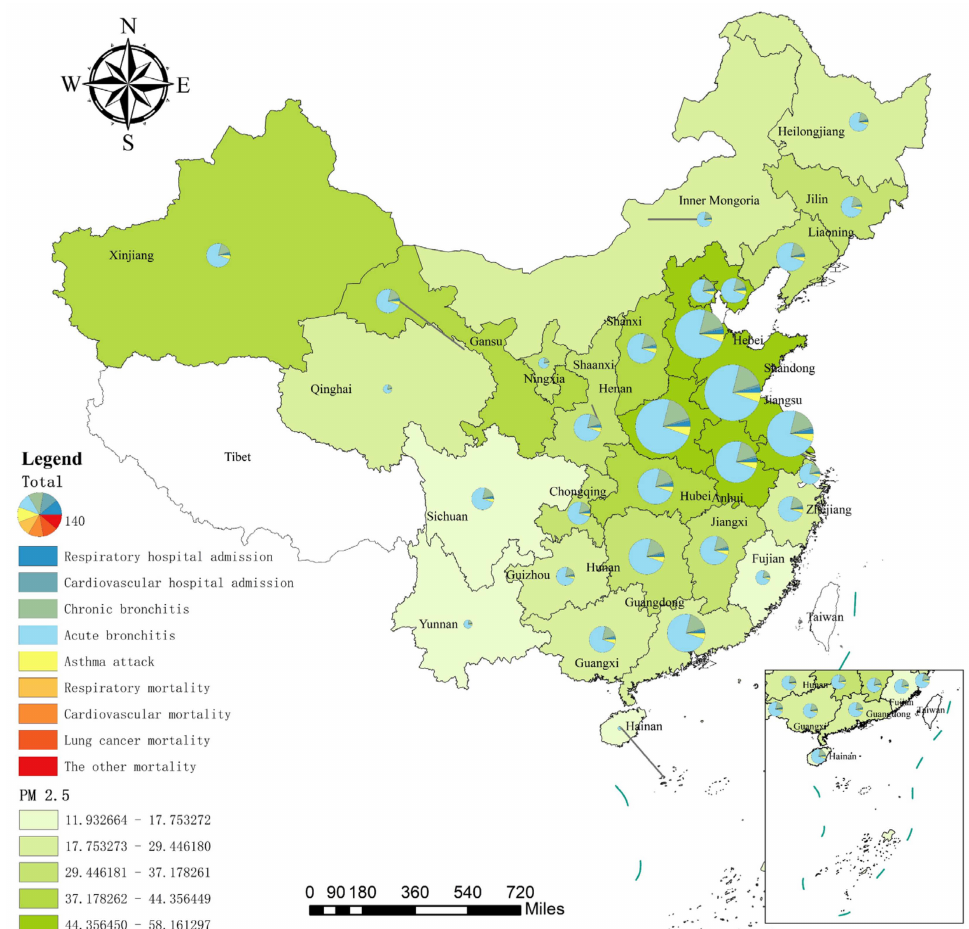
Figure 4. Spatial distribution of the health impact due to PM 2.5 exposure by province in 2017. (Notes: a. The 9 health endpoints and their respective colours are explained in the Legend. The pie chart represents the total health impact, and the green graph at the bottom is the PM 2.5 value of each province. b. Owing to the space limitations, the spatial distribution map of other years is not shown; this can be obtained from the corresponding